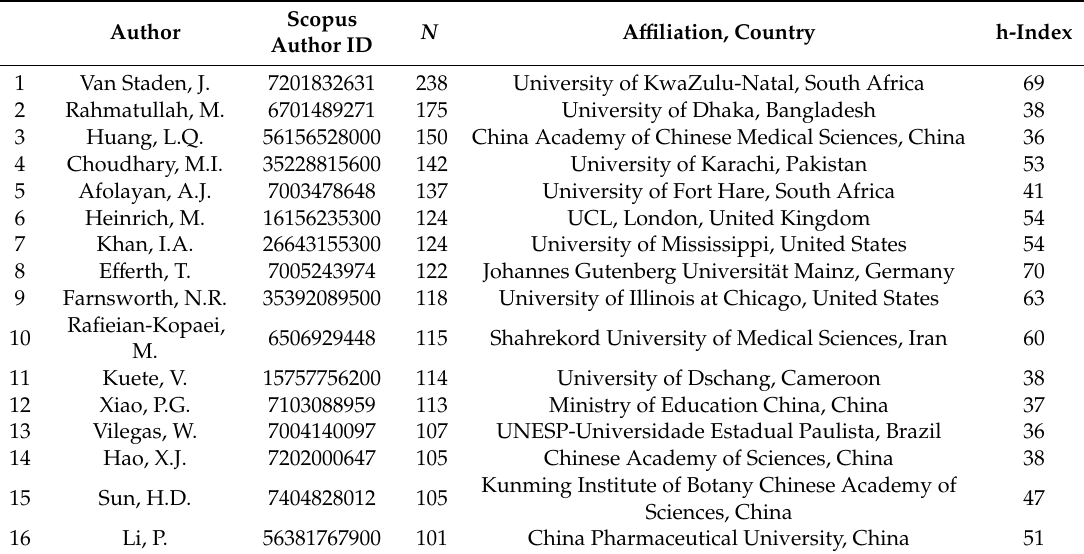
Table 2. Main authors in medicinal